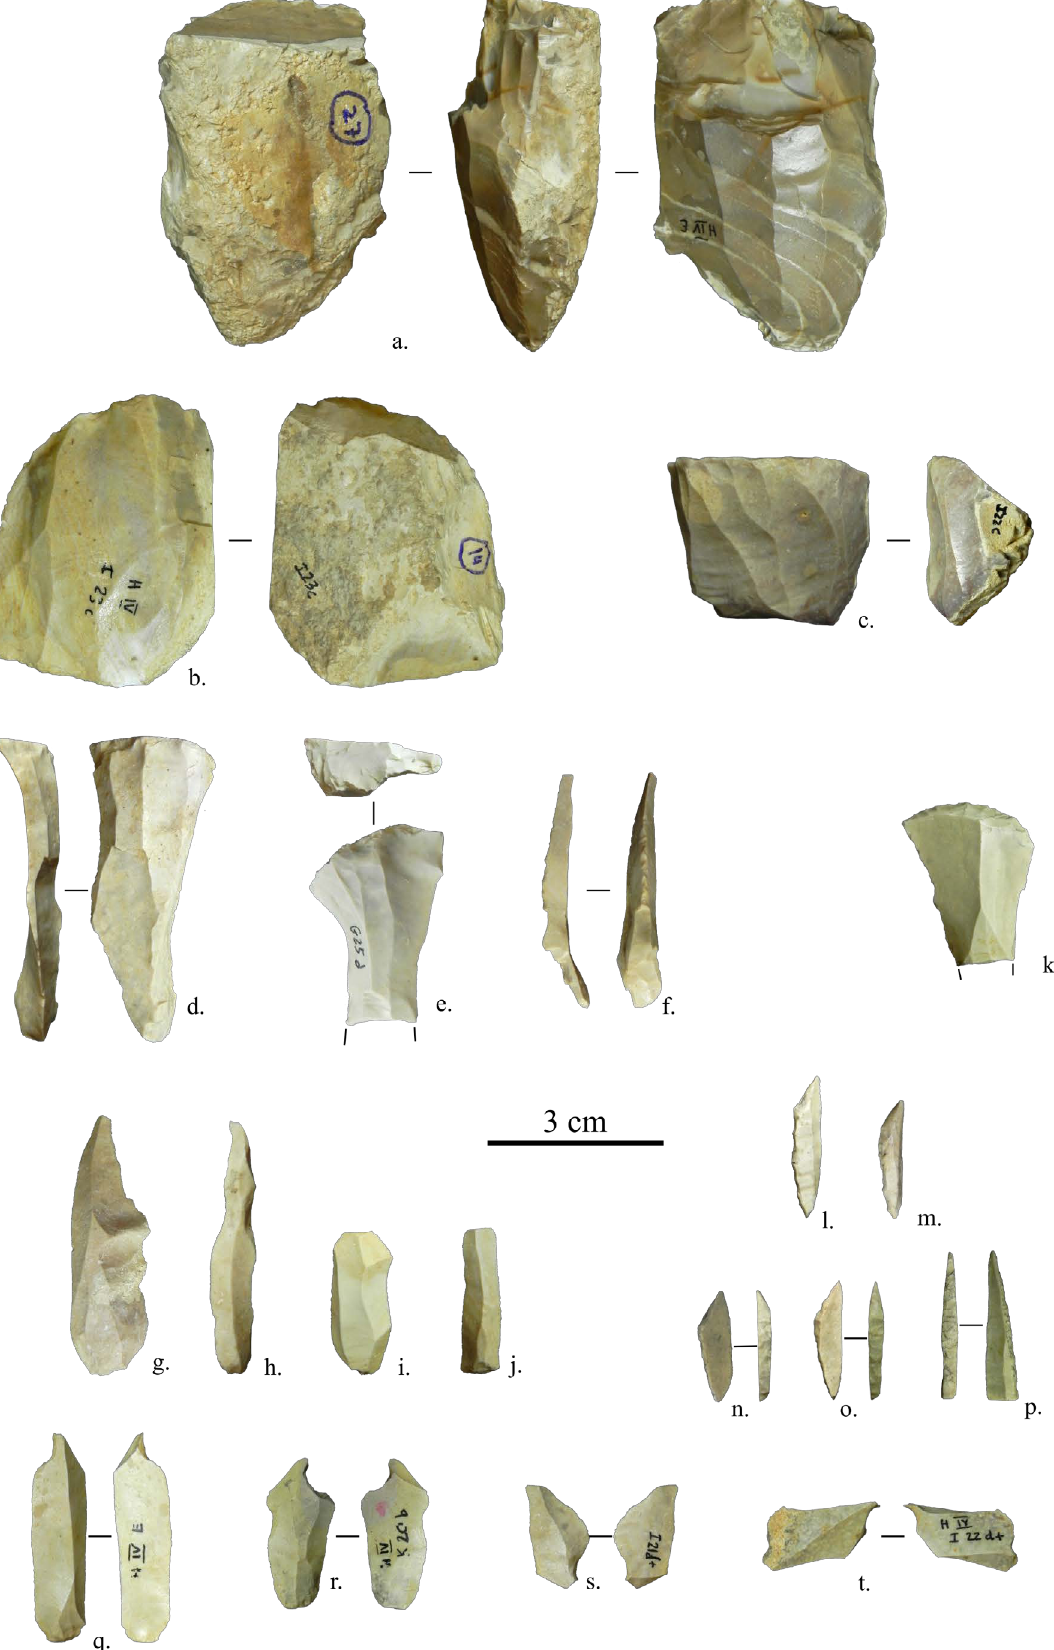
Figure 4. Hamifgash IV - lithic artefacts. (a-c) cores, (d-f) core trimming elements, (g-j) elongated blanks, (k) end-scraper, (l-0) arch-backed bladelets, (p) 'microgravette' point, (a-t)